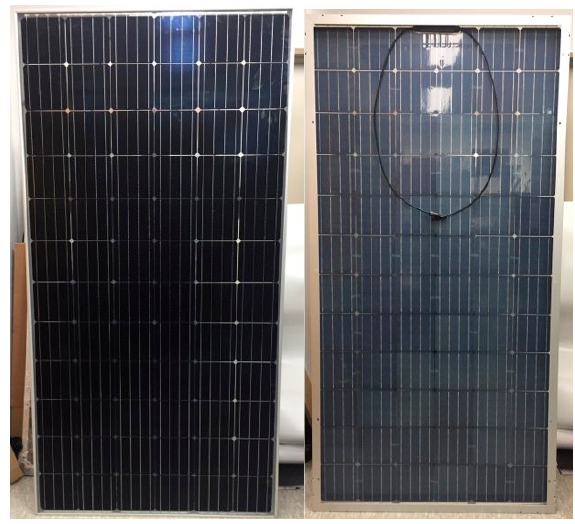
Figure 20. The 72-cell Si bifacial photovoltaic (PV) module used in application test.